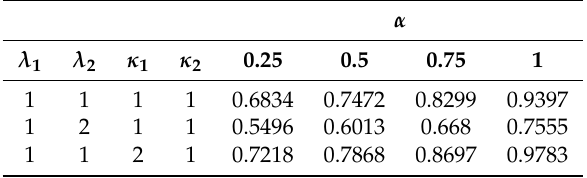
Table 1. Value of parameter p from exact